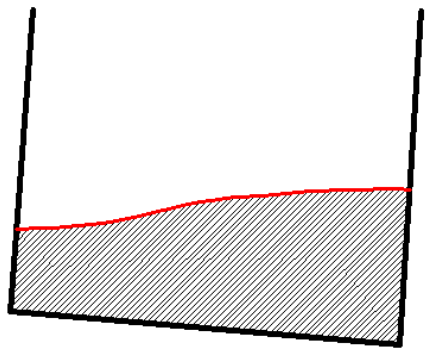
Figure 18. Flow pattern reproduced form the experiment of Chen et al. [3] ( ω = 3.09 rad/s, t = 3.55 s ) .